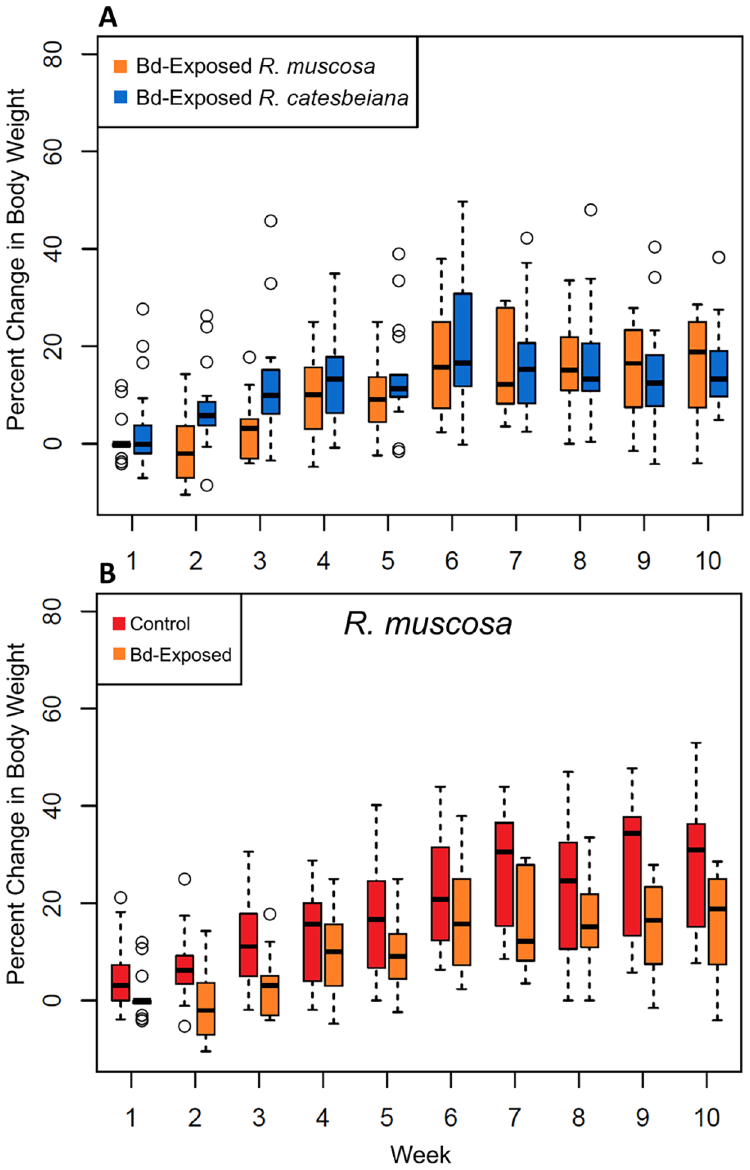
Fig 1. Percent change in body weight for each species throughout the experiment. (A) Box plot showing percent change in weight (from day 0) over the 10-week course of the experiment for R . catesbeiana Bd-exposed and R . muscosa Bd-exposed treatment groups. (B) Percent body weight change for R . muscosa Bd-exposed and control treatment groups. the duration of the experiment. Exposed R . muscosa exhibited increasing Bd loads over time, but had lower Bd loads than reported in most previous R . muscosa infection experiments (e.g., [5,41]). In contrast, exposed R . catesbeiana typically cleared (or nearly cleared) their Bd infec- tions after the first month. However, we unexpectedly discovered that some of the individuals in the R . catesbeiana control group (sham-inoculated) were positive for Bd. Although initial (pre-inoculation) skin swabs from all frogs were negative for Bd, the first post-inoculation qPCR results (day 0 of the experiment) were unexpectedly positive for this control group.